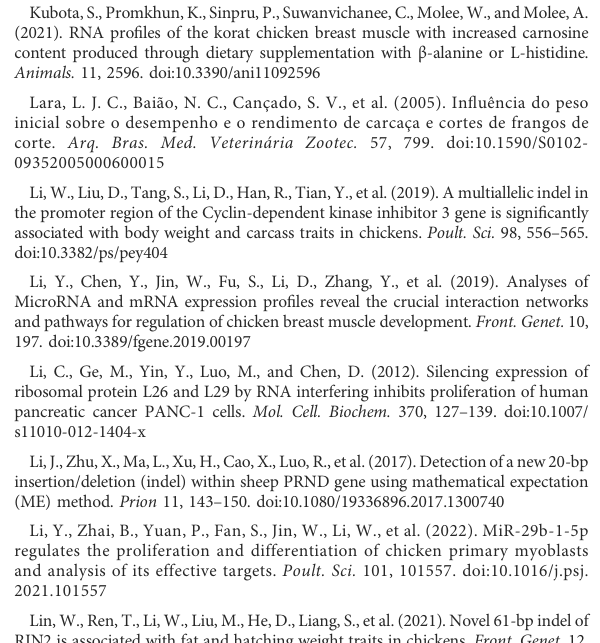
Figueiredo,V.C.,andMcCarthy, J. J. (2019). Regulation ofribosomebiogenesisin skeletal muscle hypertrophy. Physiol. (Bethesda) 34, 30 – 42.